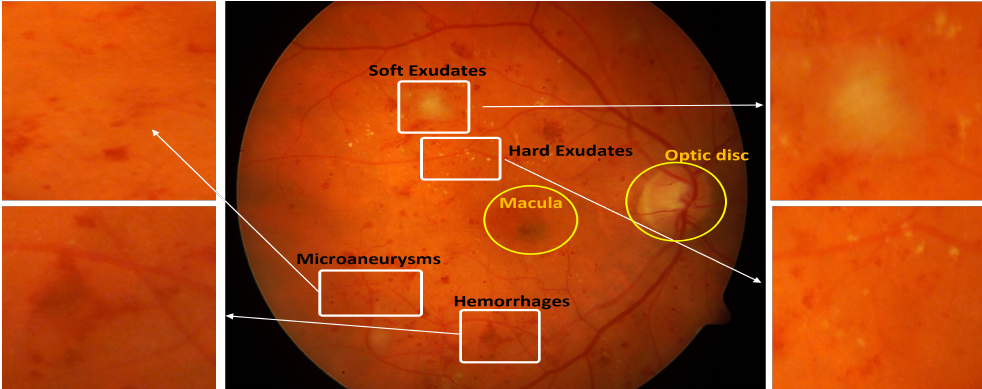
Figure 1. The retinal fundus can exhibit various types of lesions, each with its distinct appearance. Soft exudates appear as white, feathery or fluffy spots, while hard exudates are harder, uneven and have a white or yellowish appearance. Microaneurysms are small, round and have defined borders, measuring less than 3 mm in diameter, and are red in color. Hemorrhages are indications of bleeding in the retina and can manifest as dots, blots or flames. Additionally, the macula and optic disc are also